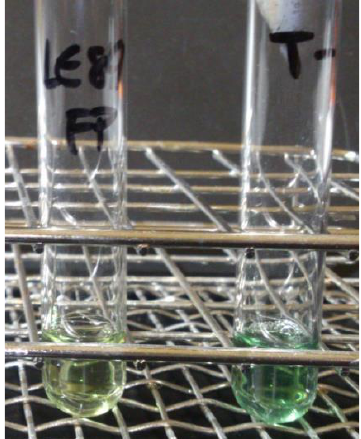
Figure 5. Presence of siderophores in the 30% protein precipitation fraction of the Pseudomonas fluorescens LE89 supernatant perceived by the color change in CAS (Chrome Azurol S/hexadecyltrimethylammonium bromide) broth medium (on the left side) versus a negative control with only PBS (phosphate-buffered saline) (on the right side).